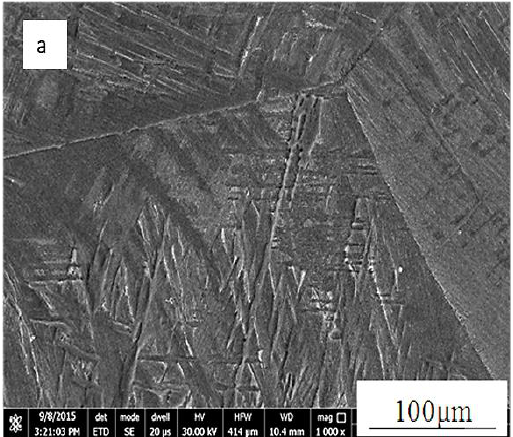
Figure 6. Microstructure of cast samples: ( a ) Ti-6Al-4V, and ( b ) Ti-6Al-7Nb.